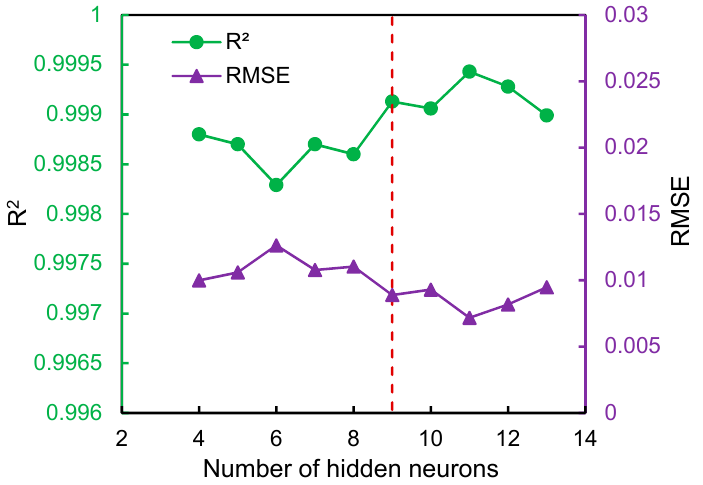
Figure 8. The training performance of the BPNN model under different numbers of hidden neurons.